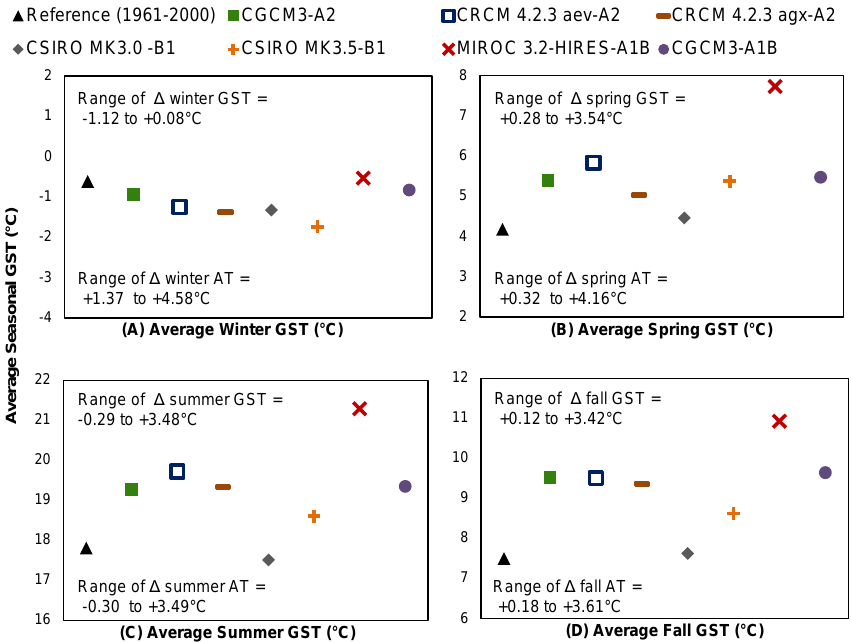
Fig. 7. ForHyM2-simulated average seasonal GST for each climate scenario (2046–2065) and the reference period (1961–2000). The y axes show various ranges in GST but are drawn to the same scale. Winter=December–February, spring=March–May, summer=June–August, and fall=September–November.